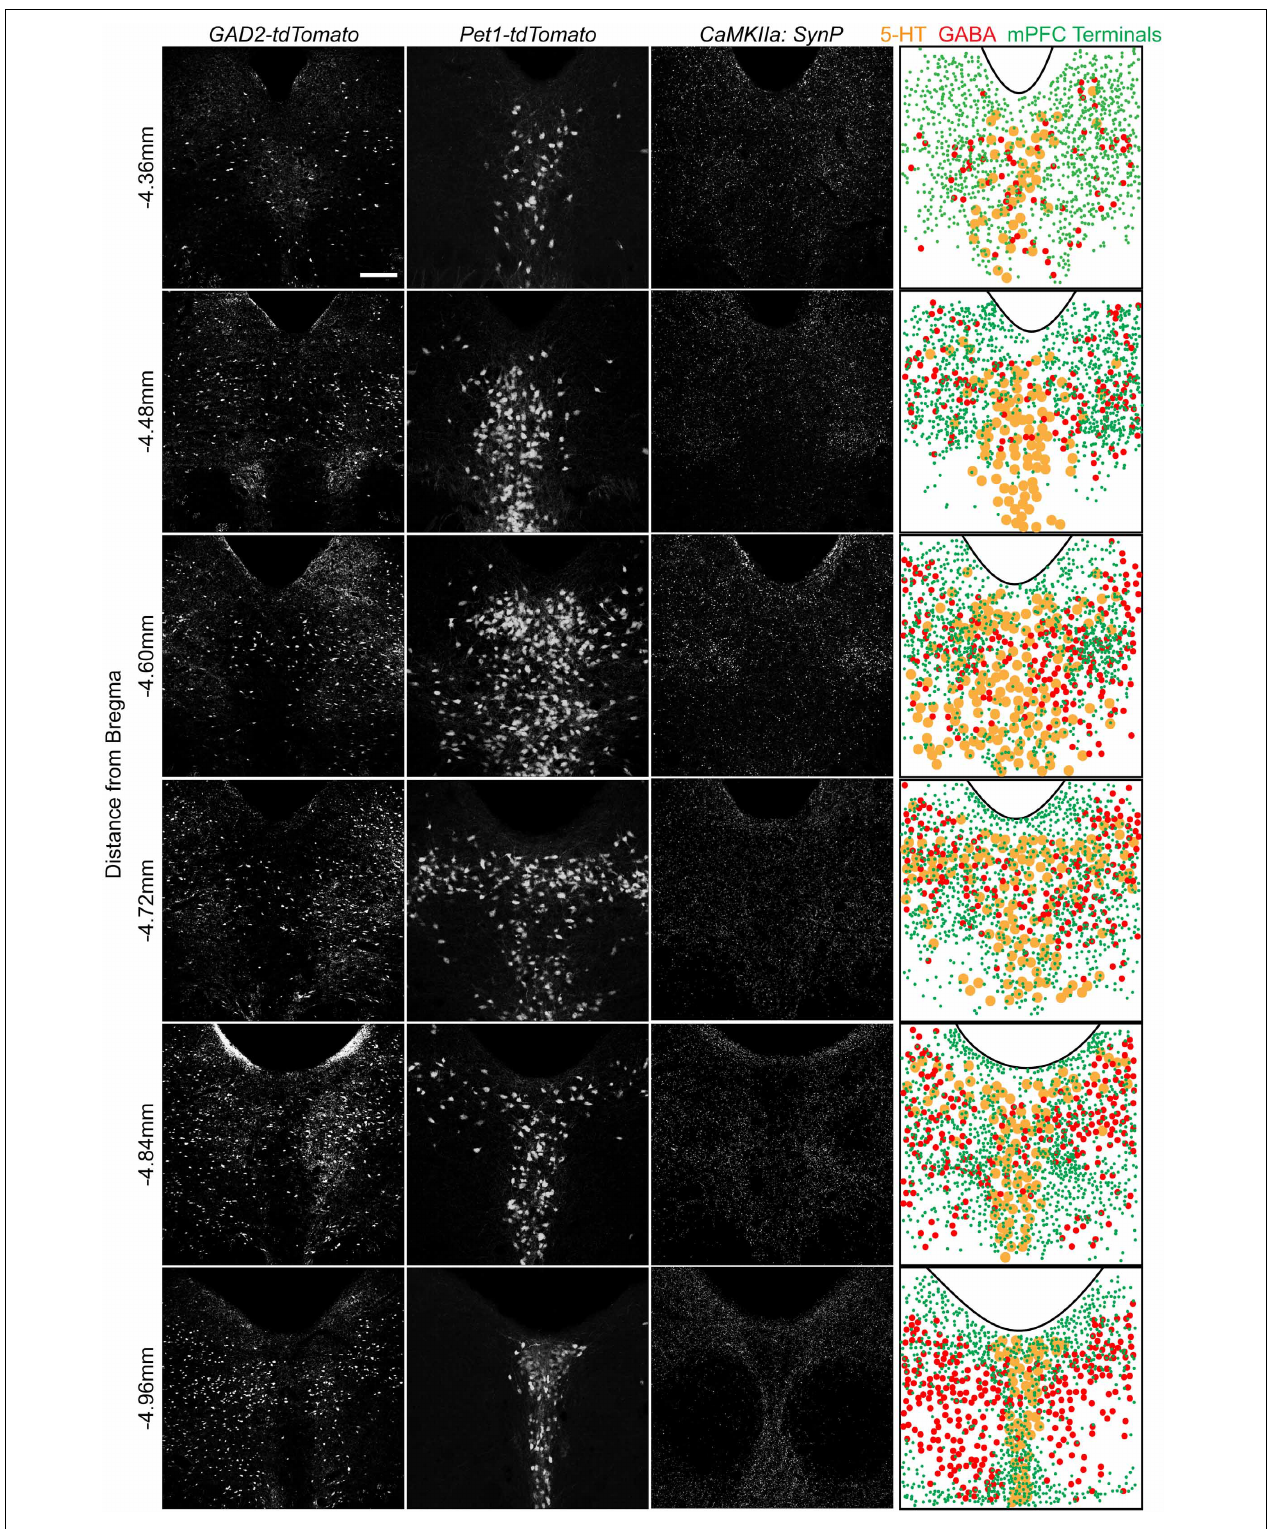
FIGURE 2 | Spatial organization of 5-HT and GABA neurons and vmPFC terminals in the DRN. Native fluorescence of GABA ( GAD2-tdTomato , column 1) and 5-HT ( Pet1-tdTomato , column 2) neurons as well as antibody